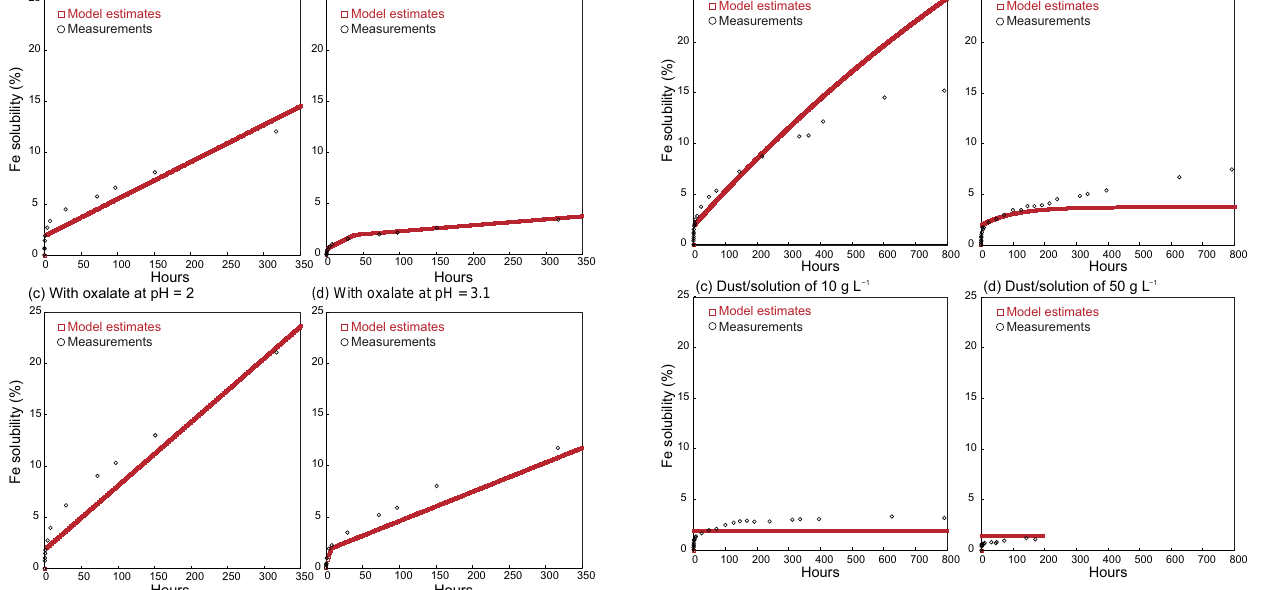
Figure 2. Comparison of Fe solubility in solution (%) predicted using Eq. (1) with our measured Fe dissolution rates (a) with no oxalate at pH = 2, 0.05M H 2 SO 4 , 1M (NH 4 ) 2 SO 4 ; (b) with no oxalate at pH = 3.1, 0.005M H 2 SO 4 , 1M (NH 4 ) 2 SO 4 ; (c) with oxalate at pH = 2.1, 0.05M H 2 SO 4 , 1M (NH 4 ) 2 SO 4 , and 0.03M Na 2 C 2 O 4 ; and (d) with oxalate at pH = 3.1, 0.005M H 2 SO 4 , 1M (NH 4 ) 2 SO 4 , and 0.03M Na 2 C 2 O 4 . The red squares are calculated using Eq. (1) from the rate constants used in this study at each hour. The black circles are our measured data. The values of pH in solution are calculated using E-AIM (Wexler and Clegg, 2002, http://www.aim.env.uea.ac.uk/aim/aim.php).